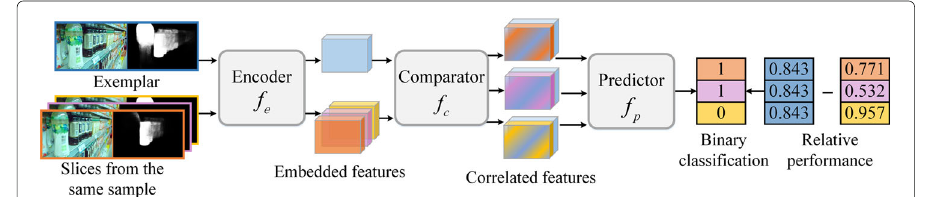
Fig. 2 Overall architecture of the proposed